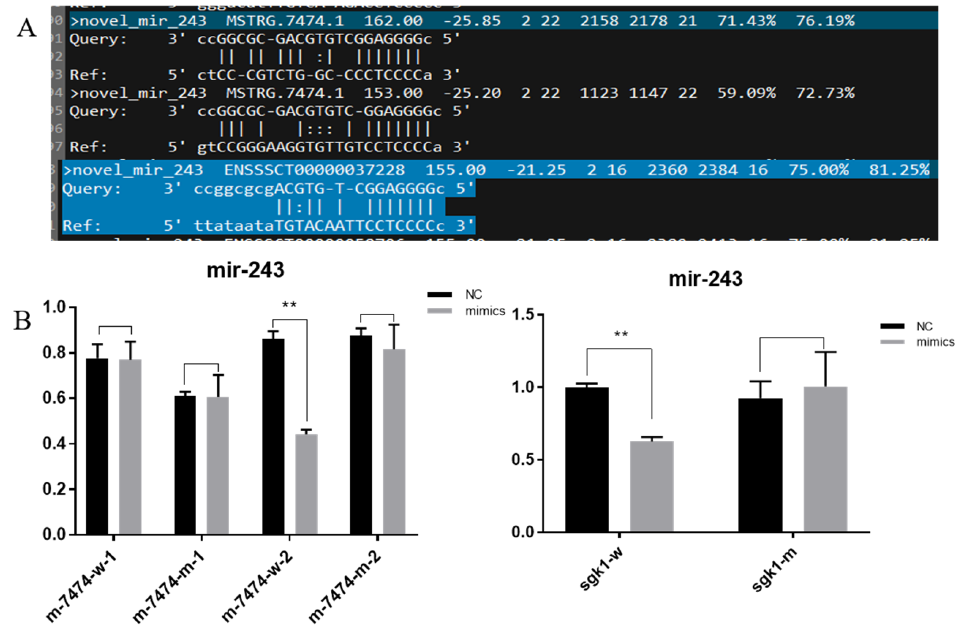
Figure 6. ( A ). MiRNA binding locations predicted by miRanda software. ( B ). Double fluorescence verification experiment. ** indicates p < 0.01, Nc is the control group, mimics refers to the overexpression of miR-243.